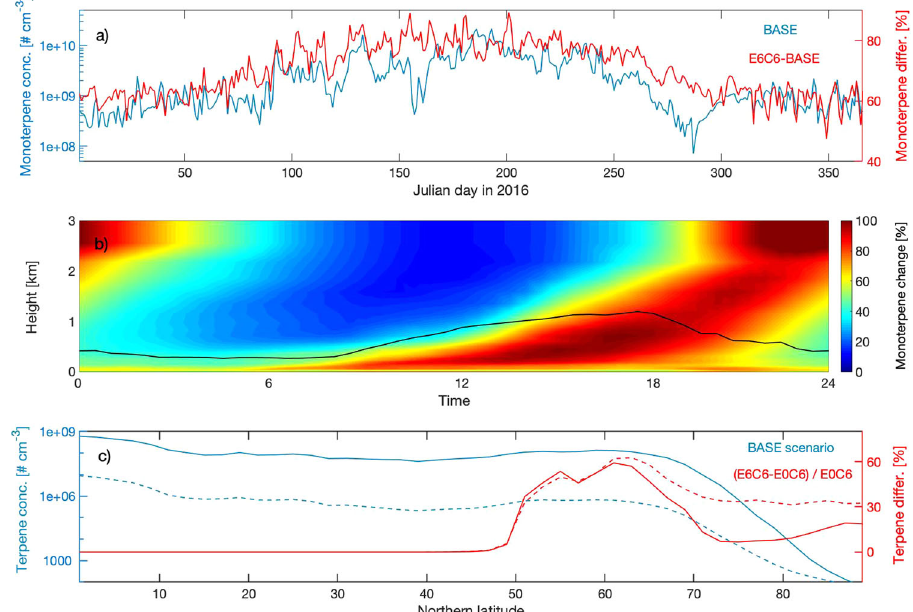
Fig. 1 Monoterpene increase by temperature. a The evolution of monoterpene concentrations in 2016 for the BASE case and the difference of the latter between the E6C6 scenario at the SMEAR II in Finland averaged for 3 km height above the surface. b The percentage change in vertical distribution of monoterpene concentration between scenario E6C6 and BASE relative to the maxima at each height level, averaged for daily distribution for the whole year 2016. The black line gives the yearly averaged planetary boundary layer height at SMEAR II. c The zonal mean values of monoterpene concentrations averaged vertically from 0 – 5 km (solid line) and 5 – 10 km (dashed line) for the Northern hemisphere calculated with the TM5 model for the BASE scenario. Added are the relative differences between the E6C6 and E0C6 scenario. The scenario abbreviations EXCX stands for E = emission, C = chemistry and X = temperature increase in the related